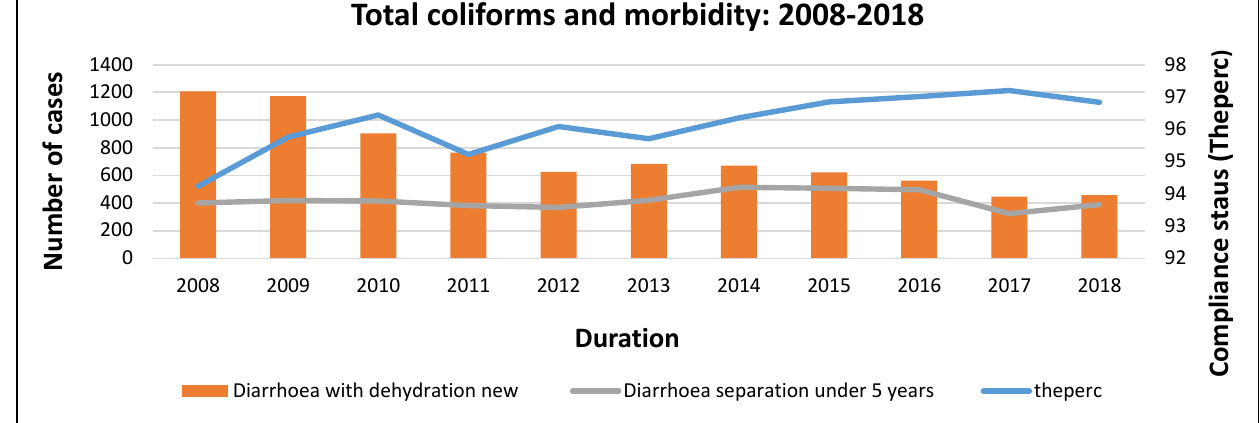
Figure 8. Total coliform and morbidity trends at the national level.